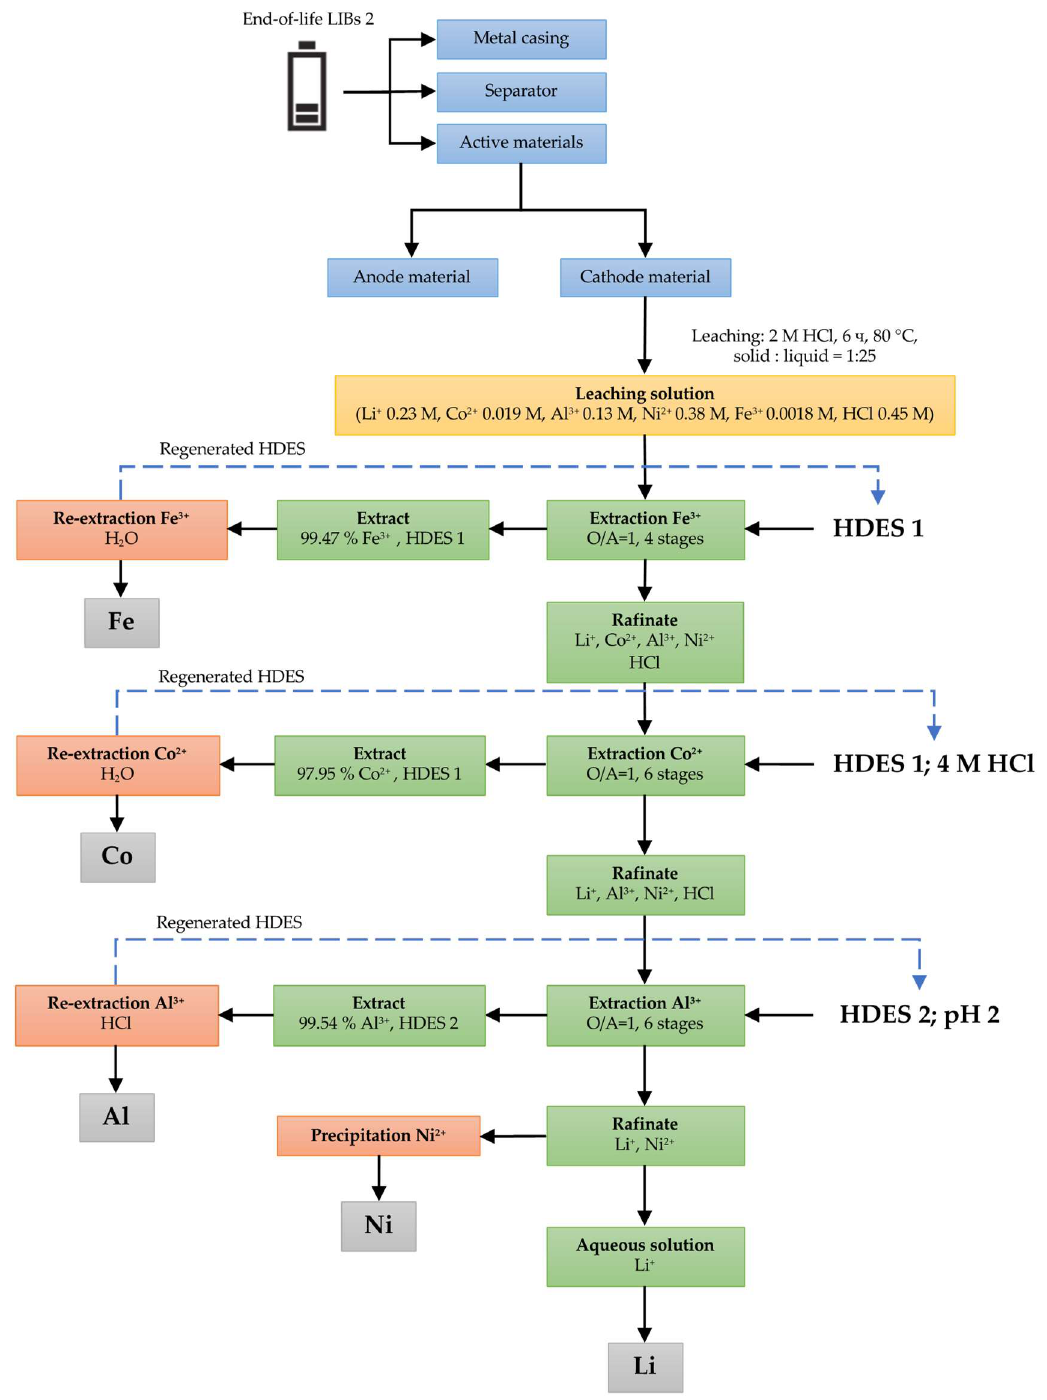
Figure 9. Scheme of LIB 2 treatment by leaching with hydrochloric acid and extraction with HDESs.